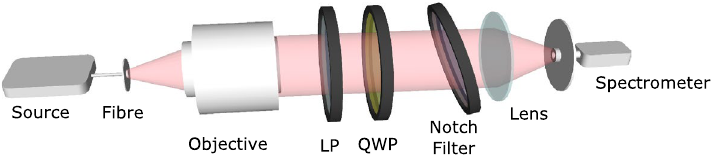
Figure 1. The experimental configuration used to capture the transmission spectra of the notch filter. Here, LP and QWP denote linear polarizer and quarter wave-plate, respectively. The schematic is not to